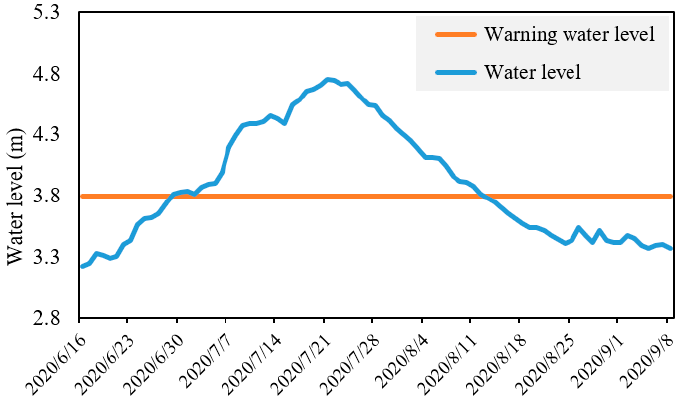
Figure 12. The water level process map of Taihu Lake. The water level data from the hydrological station were based on the Wusong elevation.